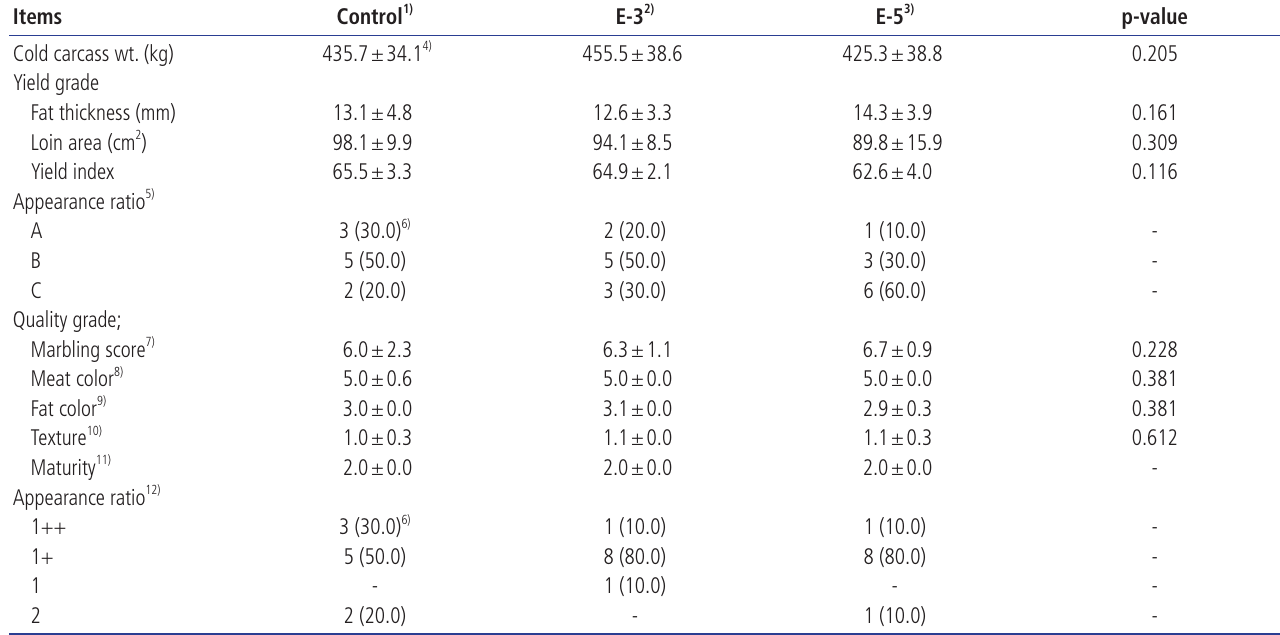
Table 3. Effects of feeding ethanol on carcass characteristics of finishing Korean cattle (Hanwoo) steers